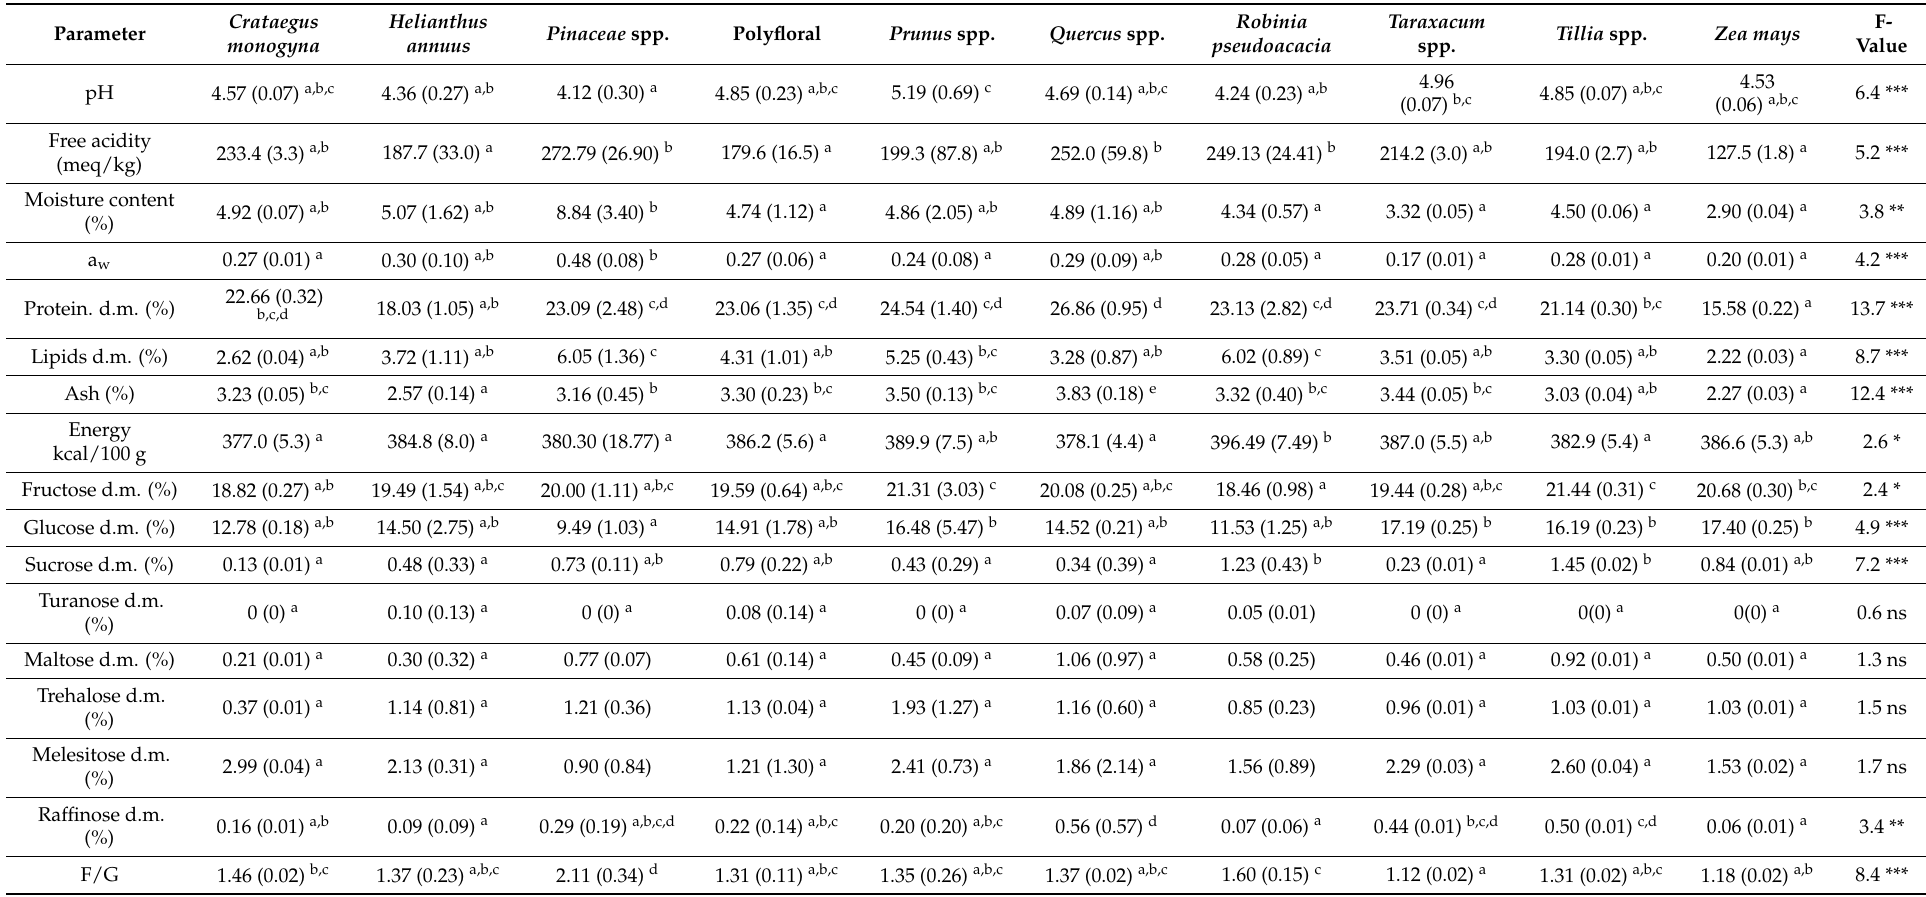
Table 2. Physicochemical parameters (moisture content, water activity, pH and free acidity), proximate composition and free sugars of bee pollen samples (mean values and standard deviation in